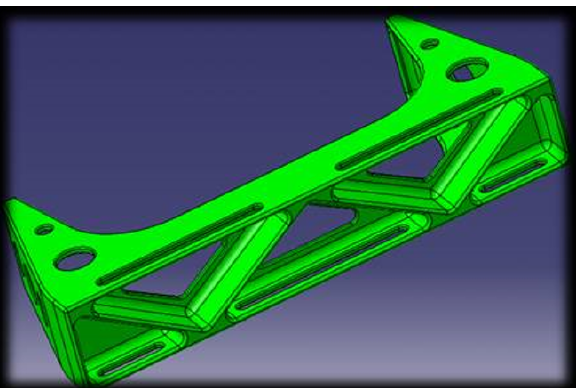
Figure 4: Front axle 2019.